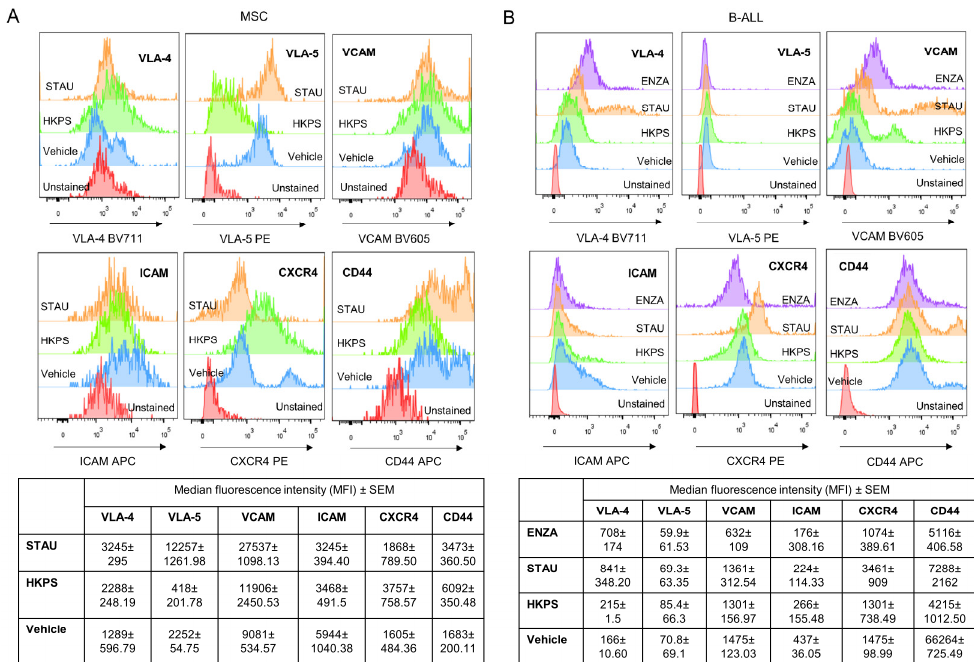
Figure 7. HKPS treatment reduces the expression of molecules involved in the MSC and B-ALL interaction. ( A ) MSC were pre-treated for 2 h with HKPS (40 µ M), STAU (0.5 µ M) or vehicle (DMSO 0.4%) and then co-cultures with B-ALL cells were stablished for 6 h. A representative experiment showing the expression of VLA-4, VLA-5, VCAM, ICAM-1, CXCR4, and CD44 evaluated by flow cytometry in CD105 + cell population. MSC alone were used as control. ( B ) Unattached B-ALL cells and B-ALL cells recovered after trypsinization from the co-cultures with MSC were labelled for assessing the expression of the indicated molecules in the CD19 + cell population. Data are expressed as mean of MFI ± SEM obtained from two independent experiments.